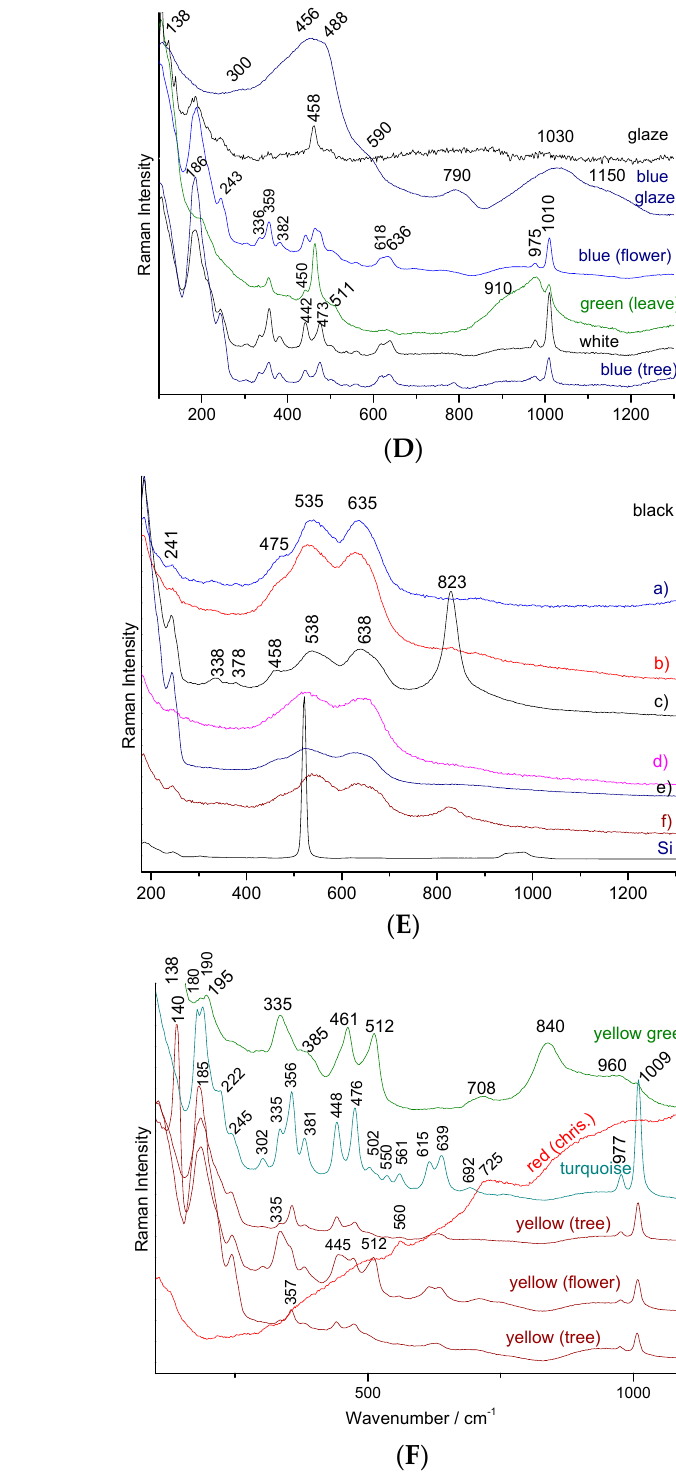
Figure 7. Representative Raman spectra recorded on a 20th porcelain with a design copying Qianlong-style production (Figure 3c); full spectral window is given on the left ( A – C ) and a zoom on the spectral range of the fundamental mode is given on the right ( D – F ): ( A , D ) colorless glaze, blue glaze, blue, green and white overglaze; ( B , E ) black lines and areas; ( C , F ) turquoise, yellow and yellow-green overglaze (See text for explanation).